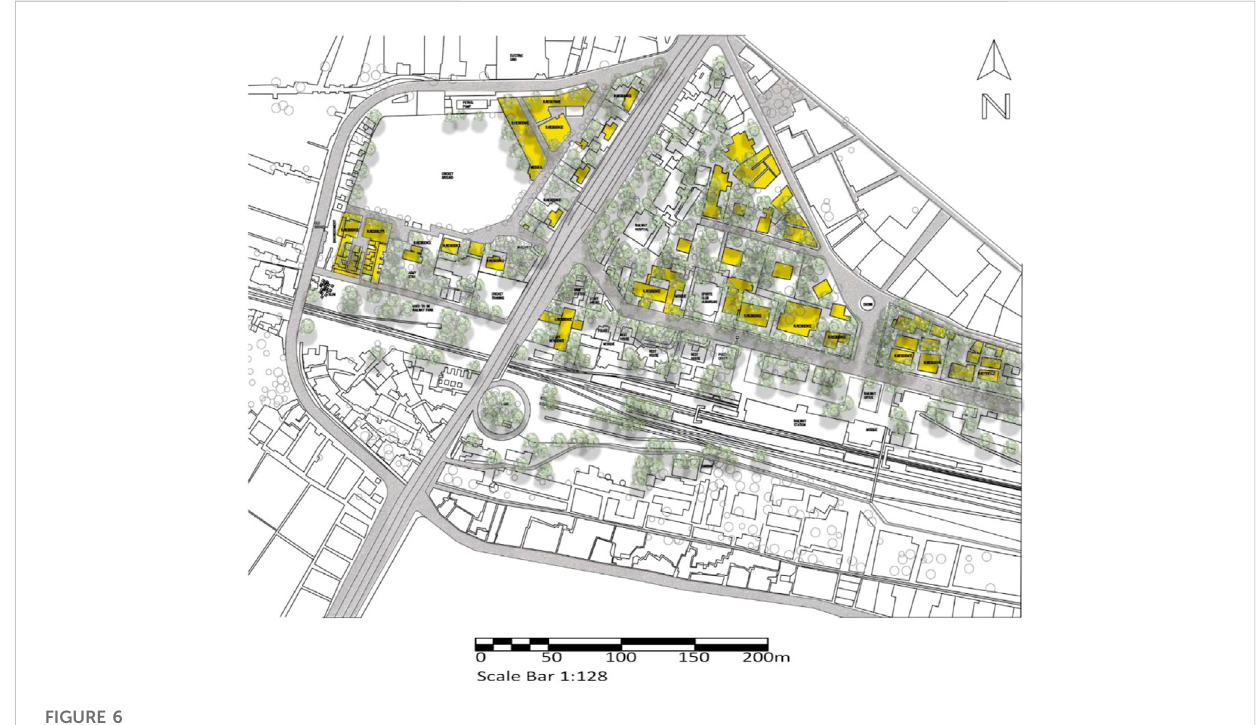
Site vegetation